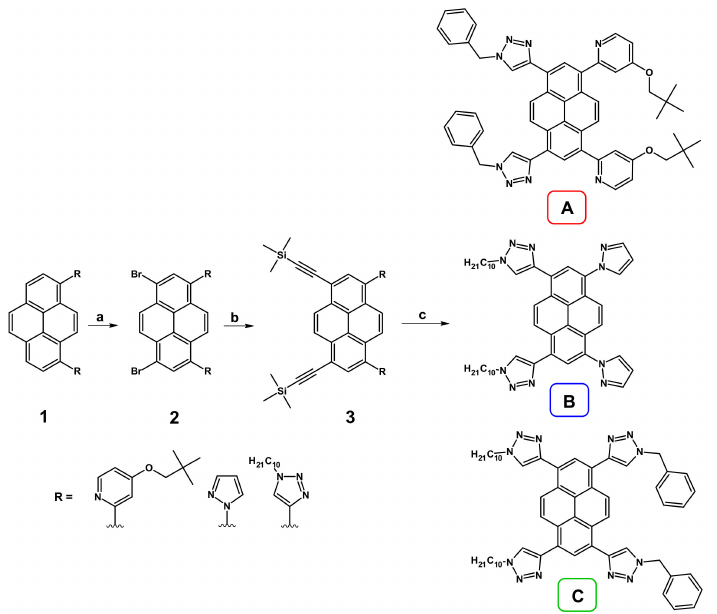
Scheme 1. Synthesis of the tetrasubstituted pyrene derivatives A – C . Reagents and conditions: ( a ) Br 2